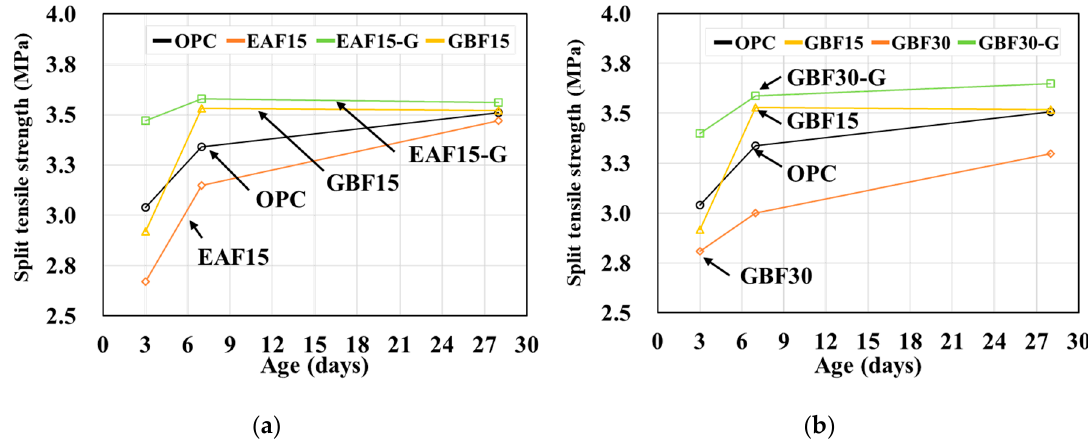
Figure 6. Split-cylinder tensile strength . ( a ) Results of EAF series and ( b ) results of GBF series.